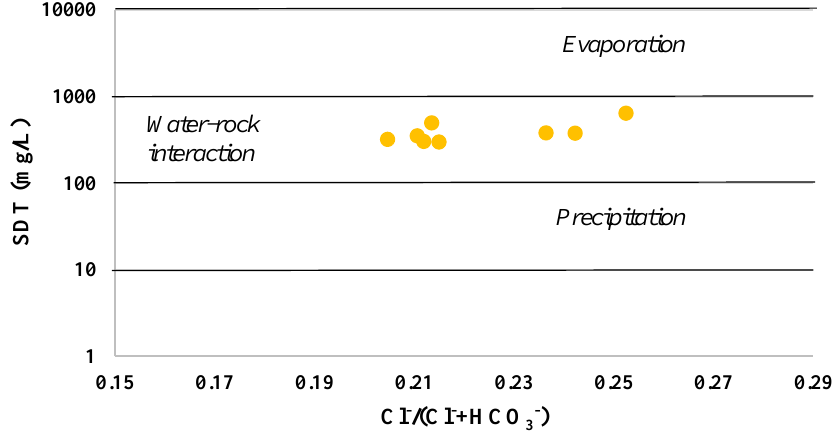
Figure 9. Gibbs diagram of the studied sites related to major anions.